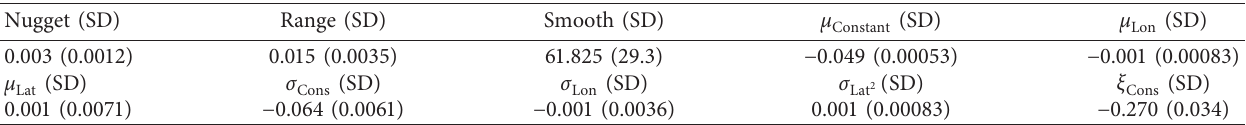
Figure 10: Interpolations of the 100 years’ return level for extreme ozone concentrations in 29 air monitoring sites versus longitude ( x -axis) and latitude ( y -axis) in South Korea. Table 4: Schlater’s model parameter estimation using the linear correlation between location and scale parameter with that of latitude and longitude (shape parameter considered constant).